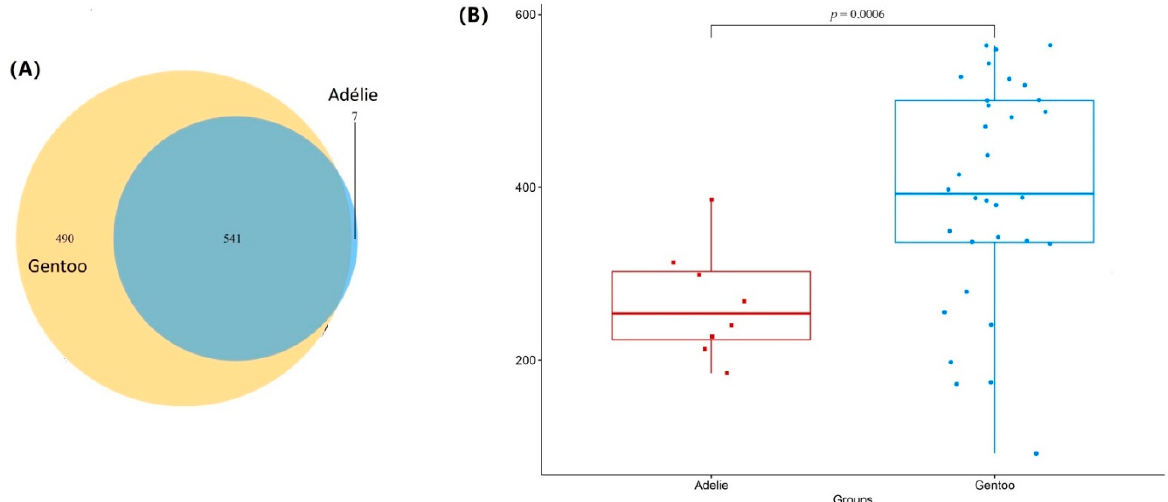
Figure 2. Lower phylogenetic diversity in the Adélie group relative to the Gentoo group. ( A ) Venn diagram showing shared and unique OTUs at 97% sequence identity of the 16S rRNA gene in the two pygoscelid penguin groups. ( B ) Student’s t -test of OTUs showing that the Adélie group was characterized by lower OTU abundance relative to the Gentoo group.